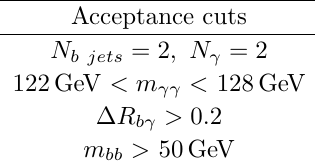
Table 1 . Acceptance cuts in the b ¯ bγγ